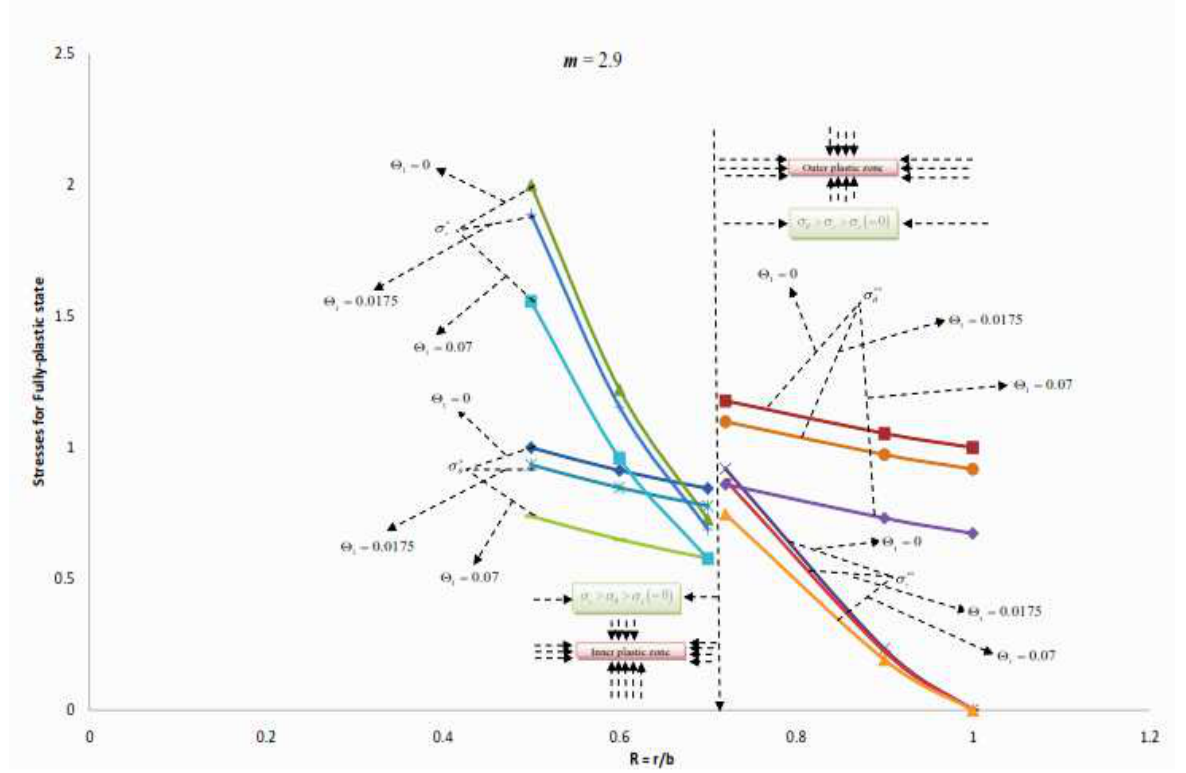
Figure 3(b). Stresses at fully-plastic state for different values of temperature and m= 2.9 with respect to radii ratio R=r/b.